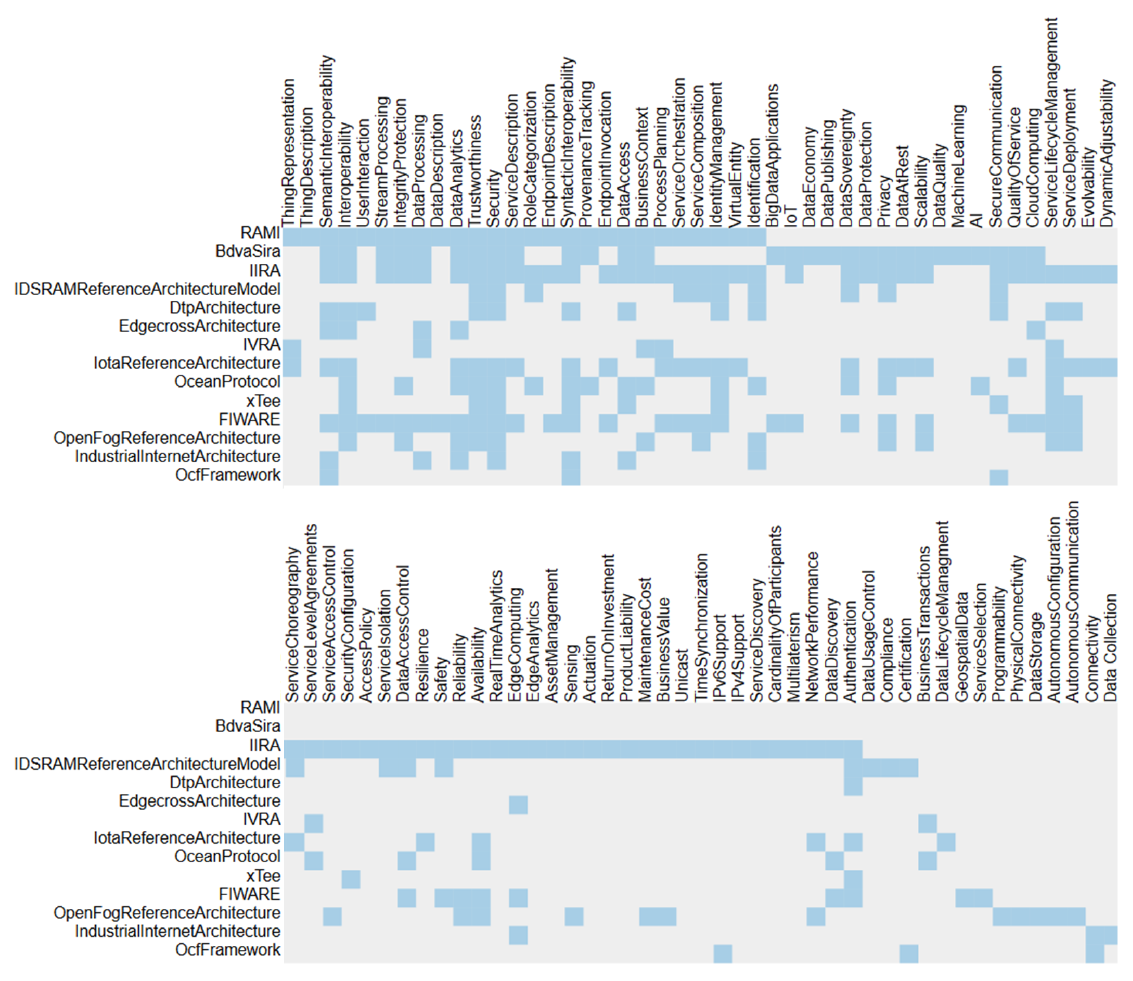
Figure 8. Concerns addressed by the frameworks as a co-occurrence matrix (http://i40.semantic-